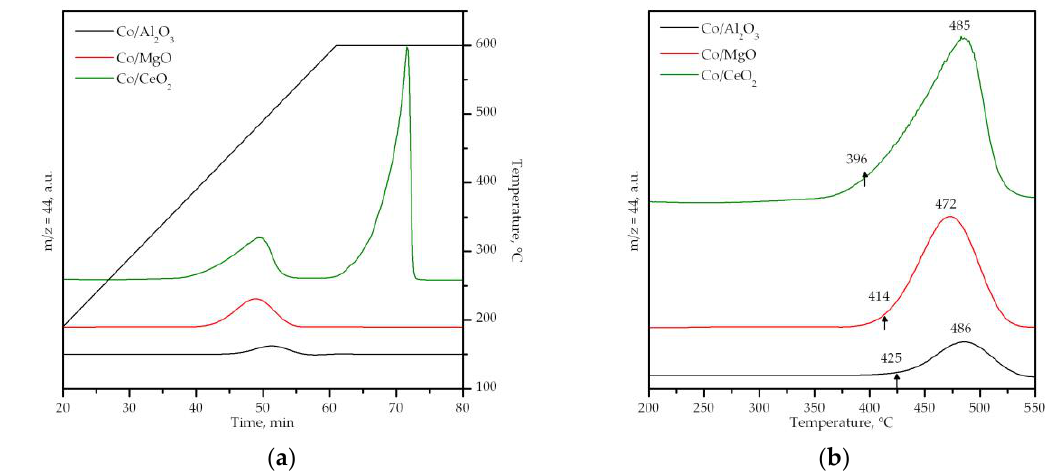
Figure 6. Profiles of the supported cobalt catalysts ( a ). Close-up view of the 200–550 °C temperature range ( b ).